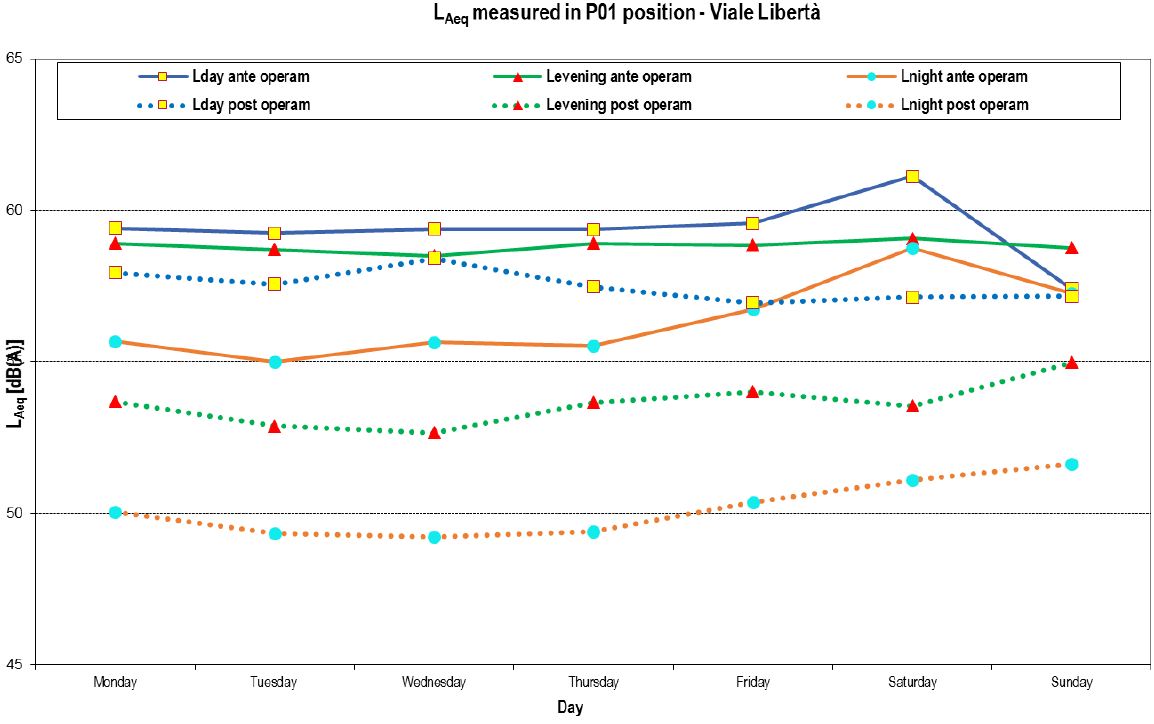
Figure 6: Comparison of sound pressure levels recorded in ante and post operam in the position of the Civic Centre